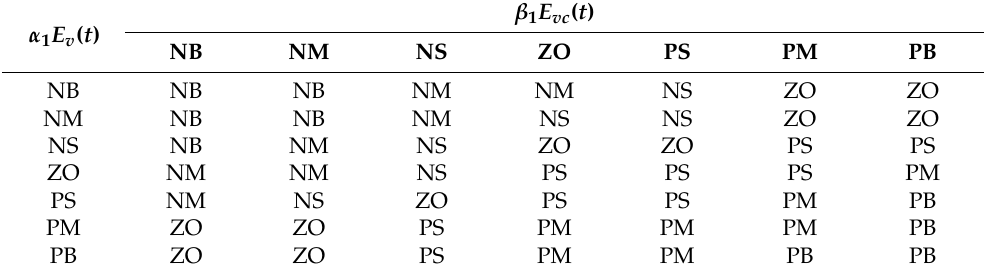
Table 3. Fuzzy rule of σ 1 ∆ K i ( t ).